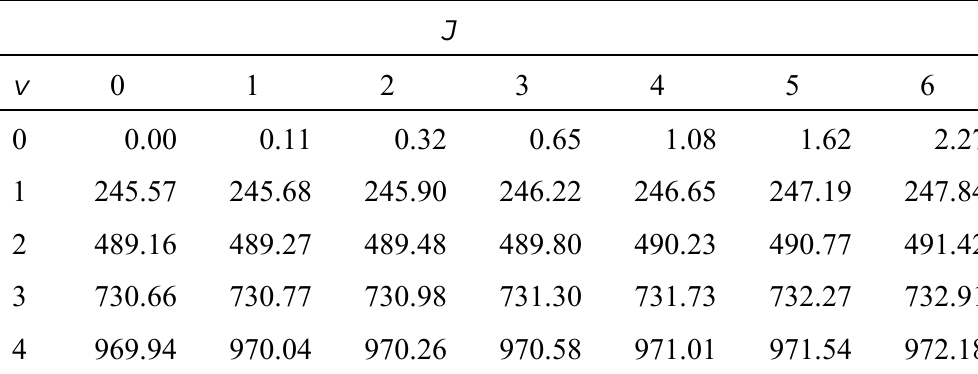
Table 2. Rovibrational energy levels of IBr obtained from potential curve calculated by MR BWCCSD in basis B (cm -1